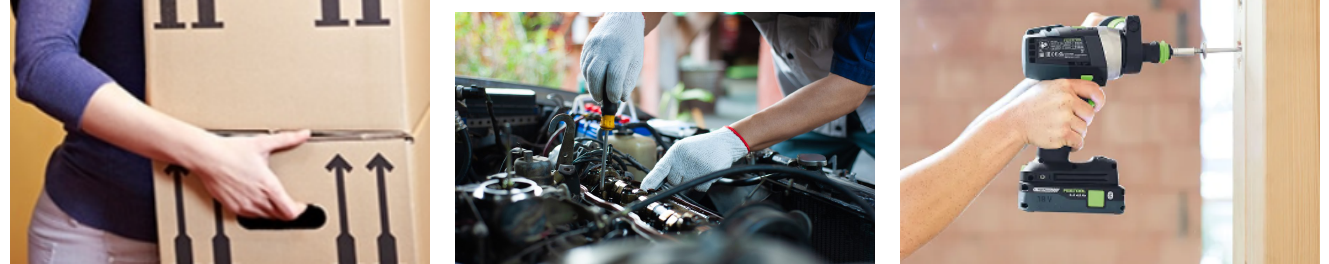
Figure 1. Example of some repetitive tasks which affect wrist